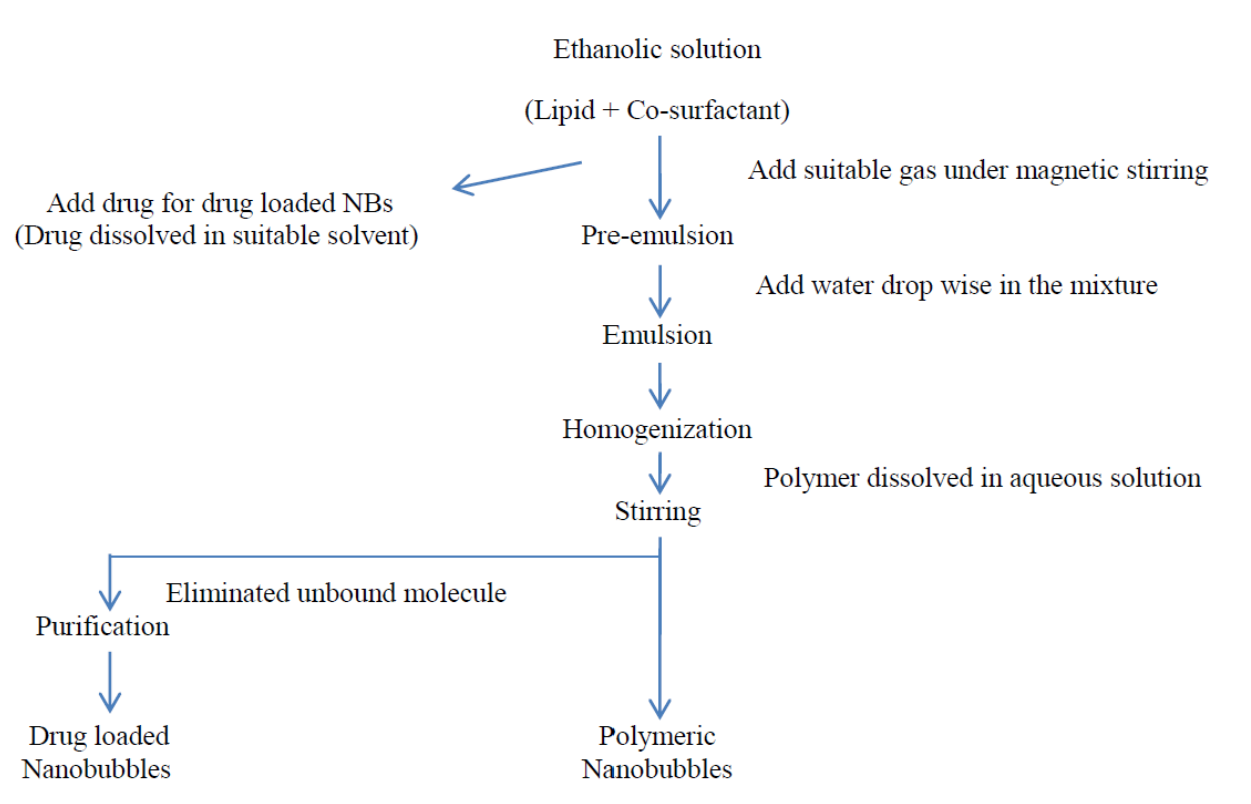
FIGURE 3 - High Shear Emulsification